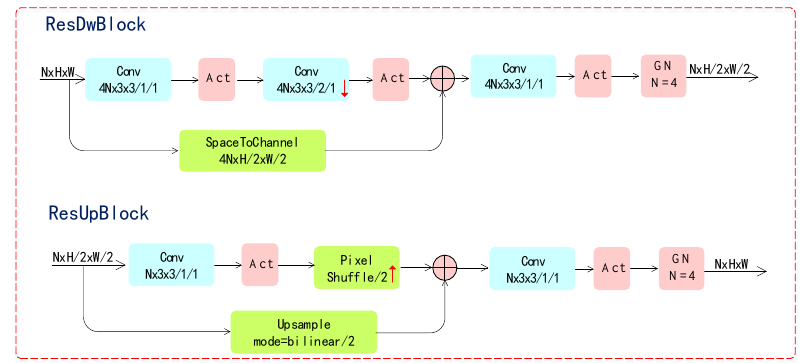
Figure 3. ResDwBlock and ResUpBlock.